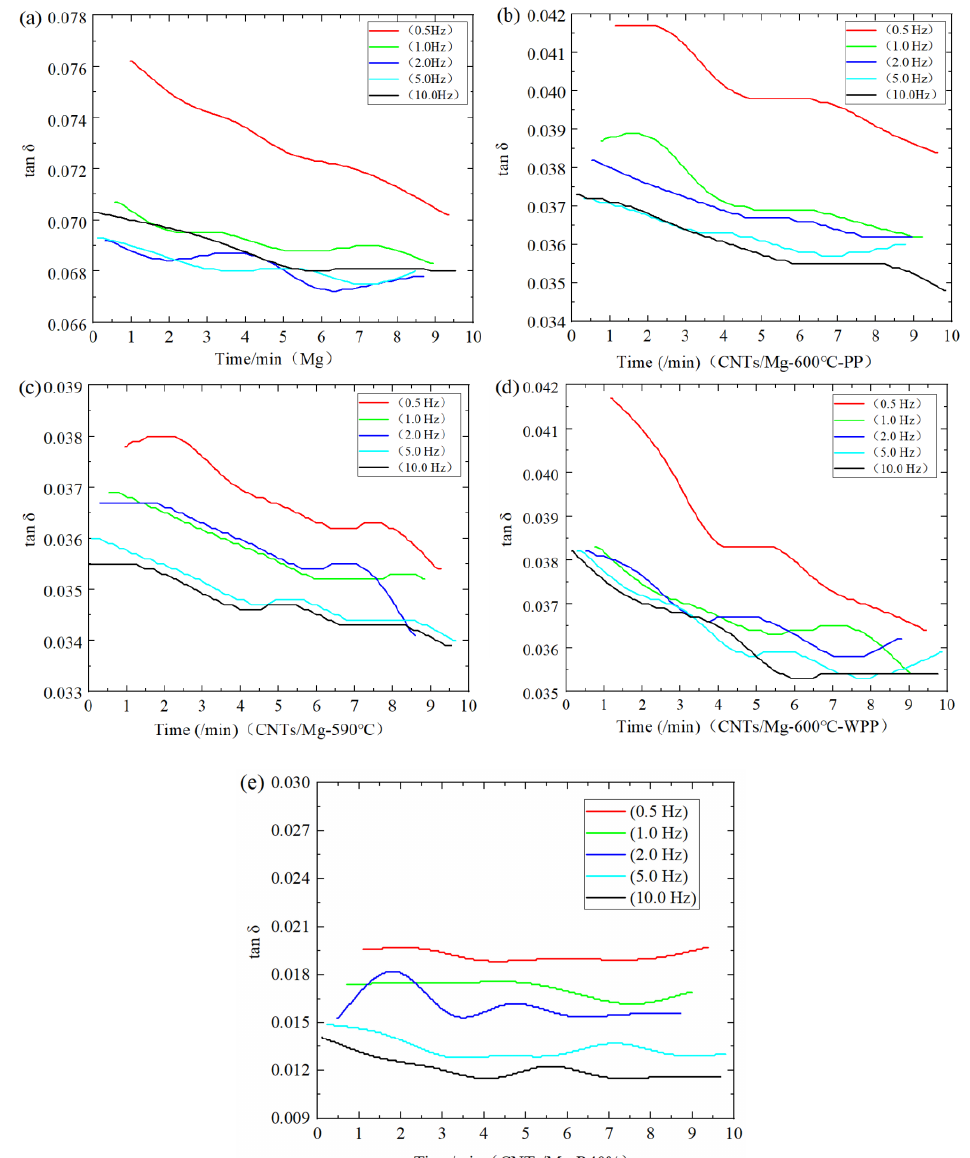
Figure 11. The tan δ ~time curve of the base material and the CNTs/Mg composite at different frequencies. ( a ) Pure Mg; ( b ) 600 ◦ C sintering; ( c ) 590 °C sintering; ( d ) 600 ◦ C sintering without preserving pressure after the end of holding time; ( e ) 590 ◦ C sintering after the pass 40% hot